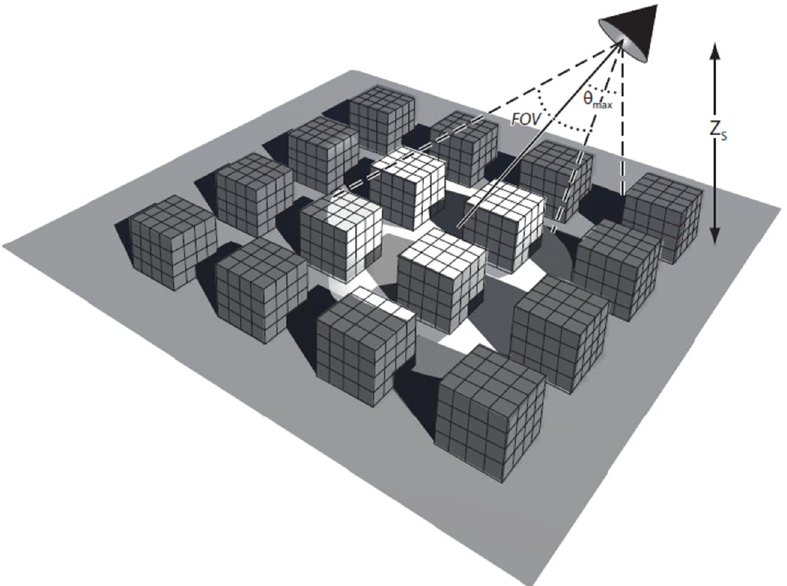
Figure 2. A schematic of a sensor at height Z S viewing a limited domain composed of regular “urban units”. θ max = maximum off-nadir viewing angle; FOV = sensor field of view.